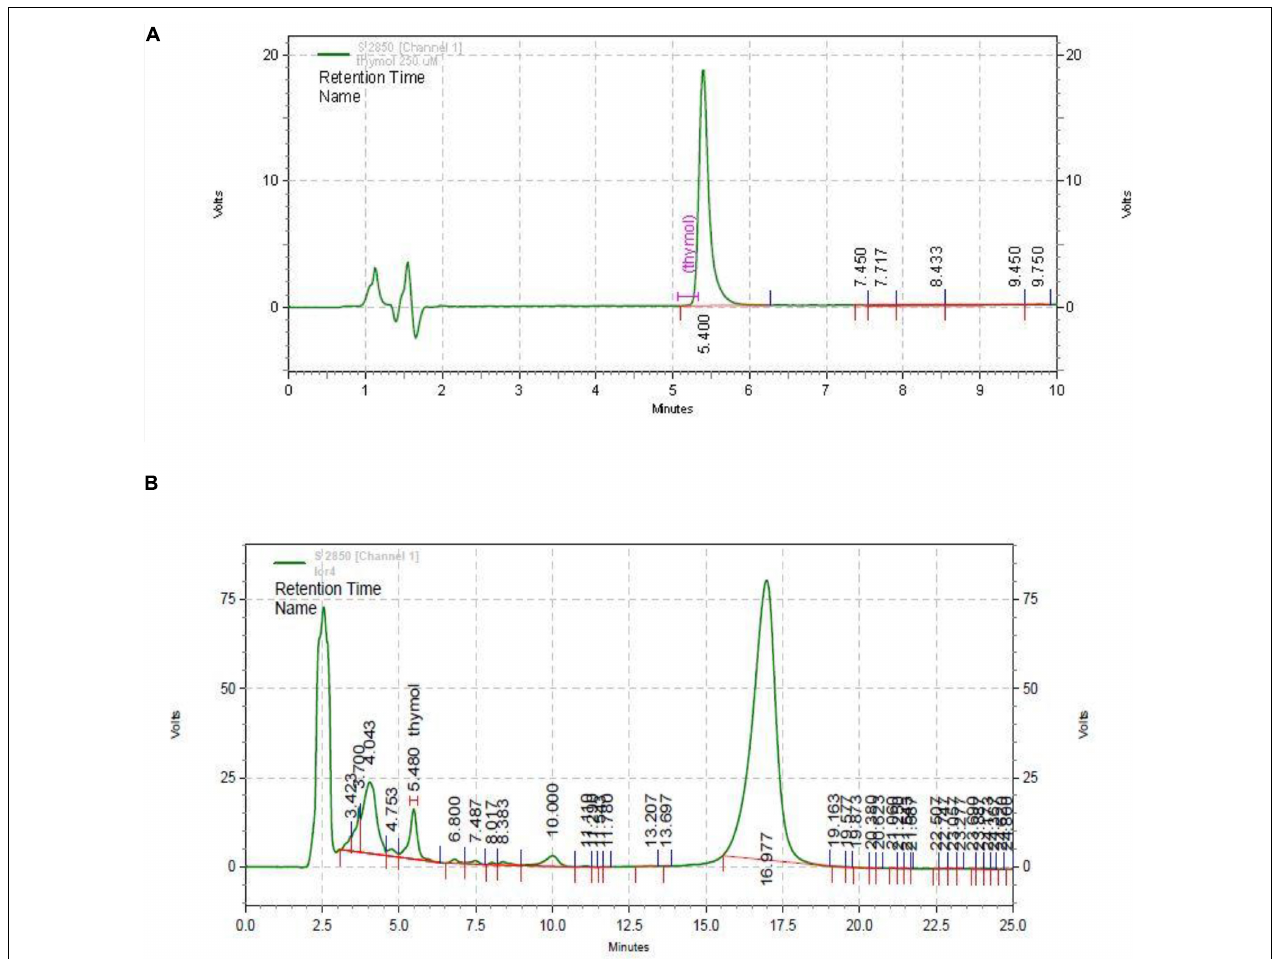
FIGURE 7 | HPLC chromatogram of thymol standard (A) and Thymbra spicata extract (B) . HPLC conditions were the same.